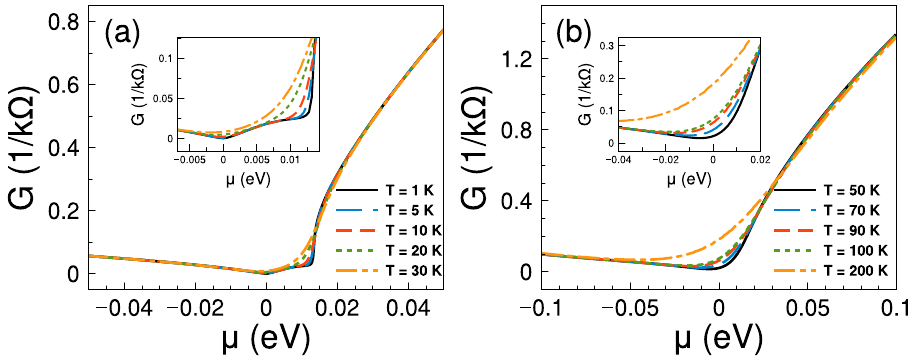
Figure 2. Conductance function versus chemical potential for gapless bilayer graphene single barriers at different temperatures: ( a ) from 1 to 30 K and ( b ) from 50 to 200 K. The single barrier structural parameters, width and height of the barriers, are d B = 6 nm and V 0 = 50 meV, respectively. The insets show a zoom of the conductance at low chemical